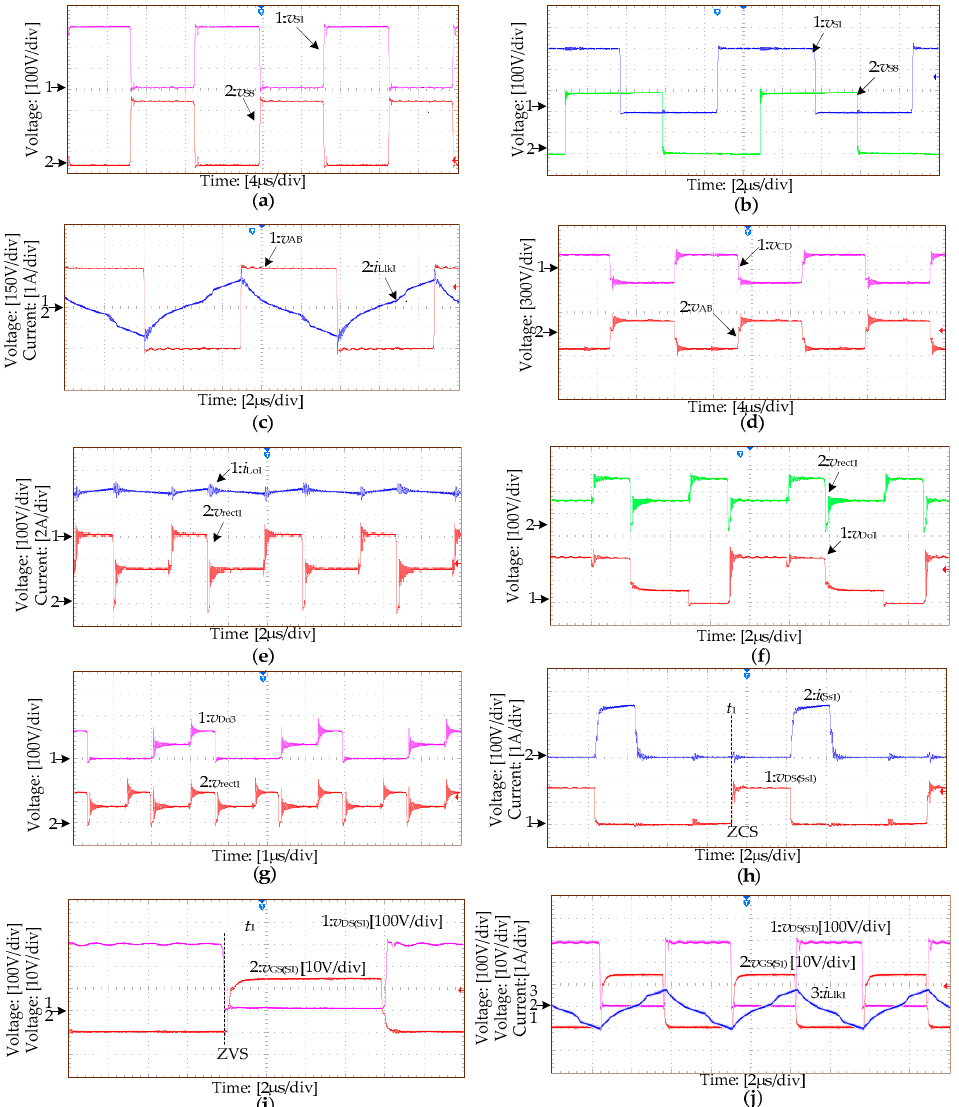
Figure 10. Experimental results: ( a ) v S1 and v S8 during the secondary side modulation (Normal operation); ( b ) v S1 and v S8 during the primary side modulation (Normal operation); ( c ) v AB and i Llk1 during the secondary side modulation (Normal operation); ( d ) v CD and v AB during the secondary side modulation (Normal operation); ( e ) i Lo1 and v rect1 during the secondary side modulation (Normal operation); ( f ) v Do1 and v rect1 during the secondary side modulation (Normal operation); ( g ) v Do3 and v rect1 during the secondary side modulation (Normal operation); ( h ) ZCS of S s1 ; ( i ) ZVS of S 1 with zero load current; ( j ) v DS(S1) , v GS(S1) and i Llk1 during the secondary side modulation (Failure mode